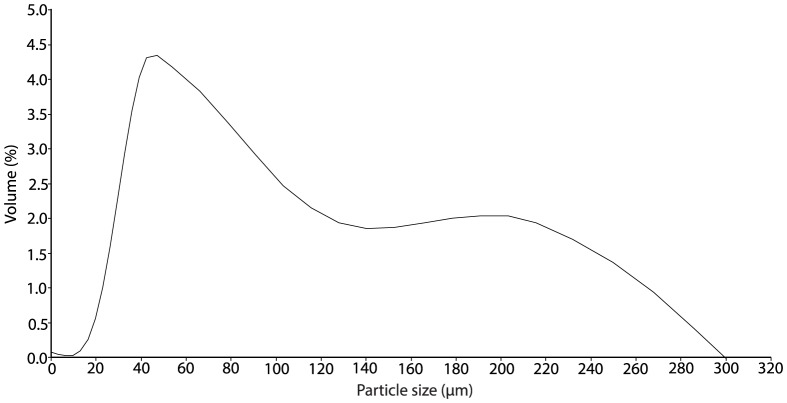
The sediment particle profile of the silicon carbide powder.